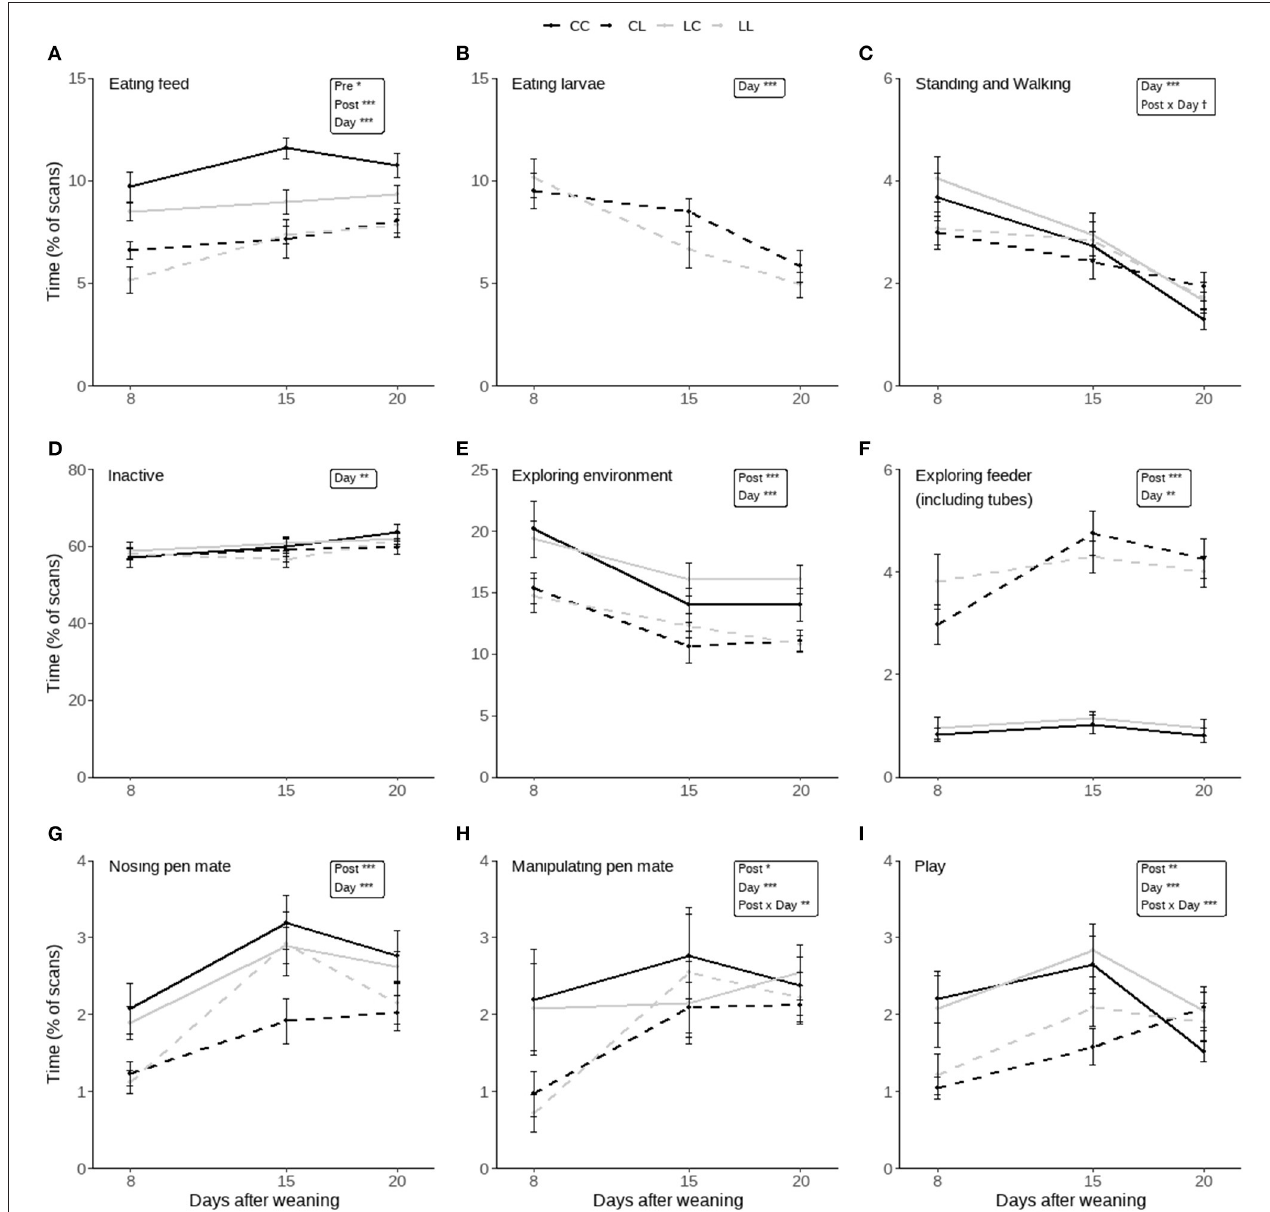
FIGURE 5 | Time spent on behaviors scored during the post-weaning home pen observations of piglets that had access to either only creep feed (Pre-C) or creep feed and live black soldier fly larvae (Pre-L) pre-weaning, and consequently had access to no larvae (Post-C) or had access to live black soldier fly larvae